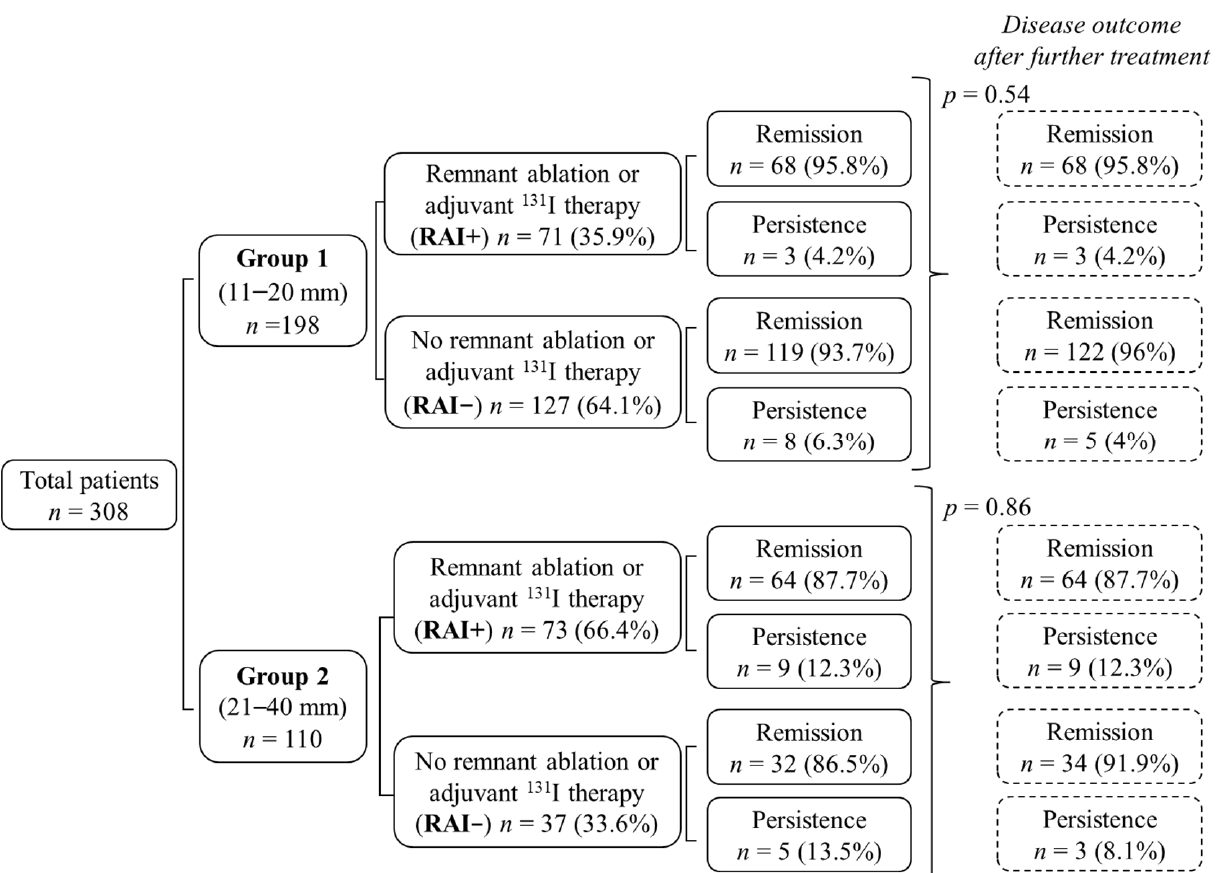
Figure 1. Outcome at the last follow up visit of patients of Group 1 (11–20 mm) and Group 2 (21–40 mm). After surgery, patients were submitted to radioiodine ablative/adjuvant treatment (RAI+) or not (RAI − ). The outcome after eventual additional treatment of persistent cases is also shown (see Table 2 for